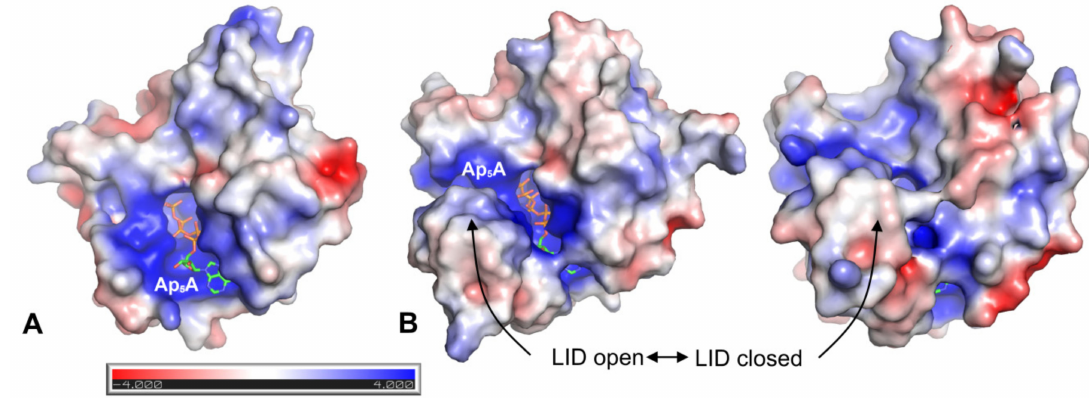
Figure 8. Electrostatic potential mapped on the solvent-accessible surface of ( A ) hAK1 (PDB ID: 1Z83) in the closed state and ( B ) AKst in the open (PDB ID: 1ZIN) and closed (PDB ID: 4QBH) state. Cofactor Ap 5 A is shown in sticks representation. Electrostatic potential was calculated using APBS plugin 2.1 to